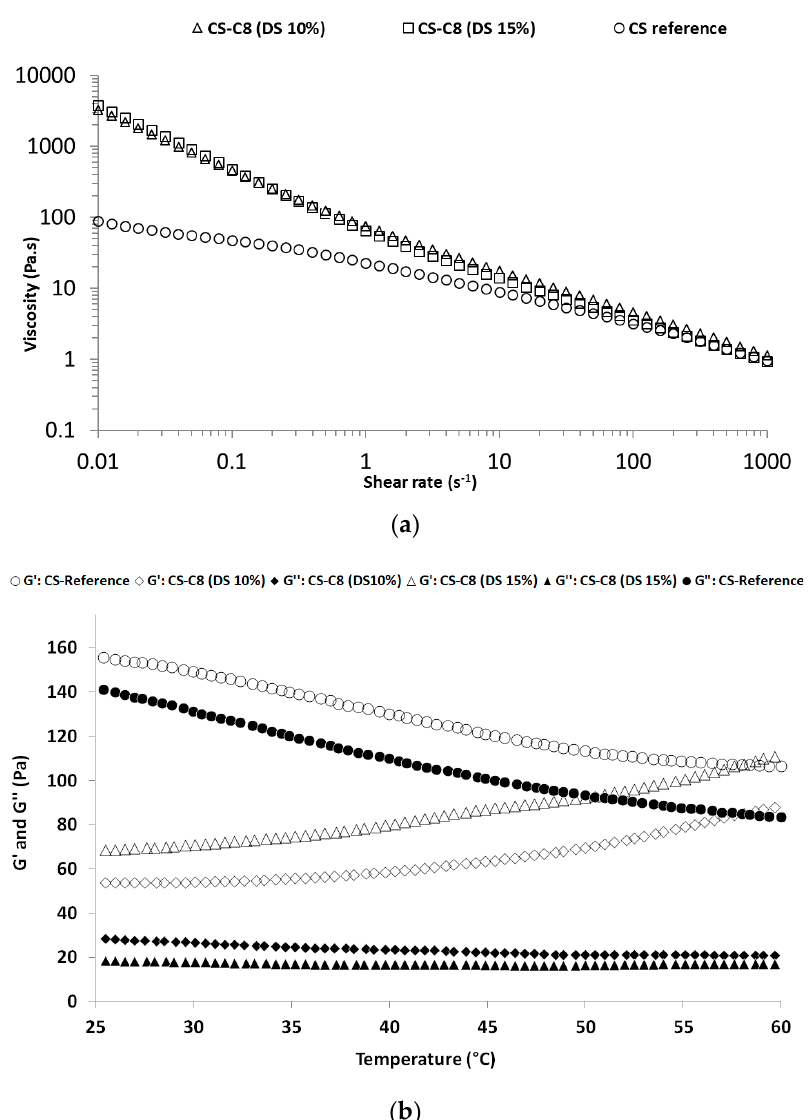
Figure 2. ( a ) Influence of the shear rate on the rheological curves of the solutions of native chitosan (CS-Reference) and alkyl-chitosans (DS of 10 and 15%) at 4% ( w / v ) in 1% acetic acid; ( b ) Plot of elastic modulus (G (cid:48) ) and loss modulus (G”) as a function of temperature on chitosan (CS-Reference) and alkyl-chitosans (DS of 10 and 15%) at 4% ( w / v ) in 1% acetic